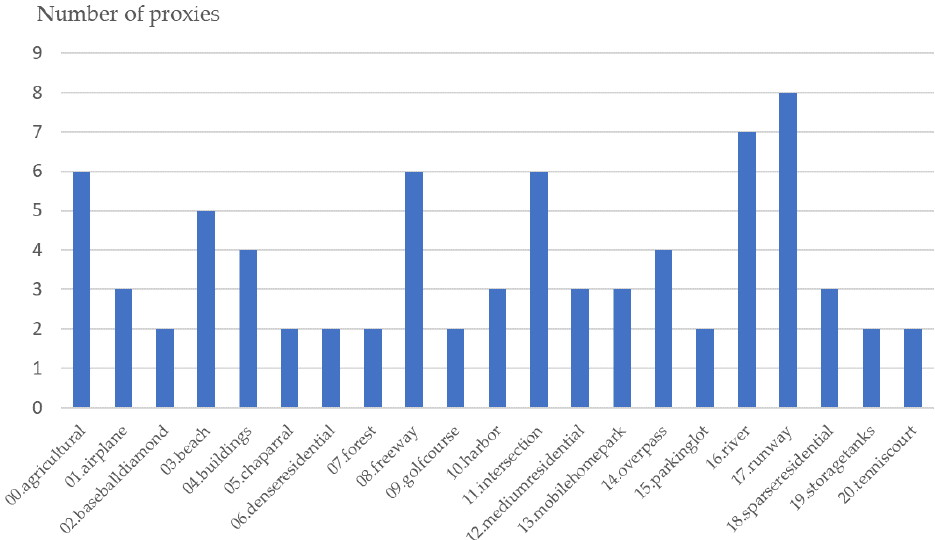
Figure 10. The number of proxies assigned to each class in the UCMD dataset by our proposed adaptive multi-proxy assignment